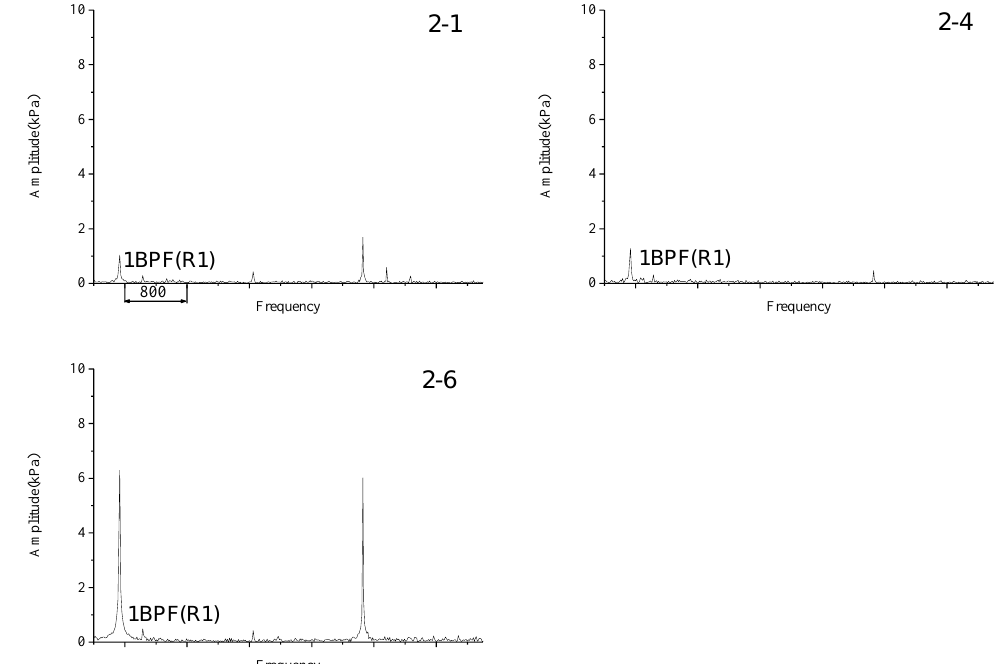
Figure 26 . Changes in the pressure frequency spectrum inside R2, at the surge limit . Figure 26. Changes in the pressure frequency spectrum inside R2, at the surge